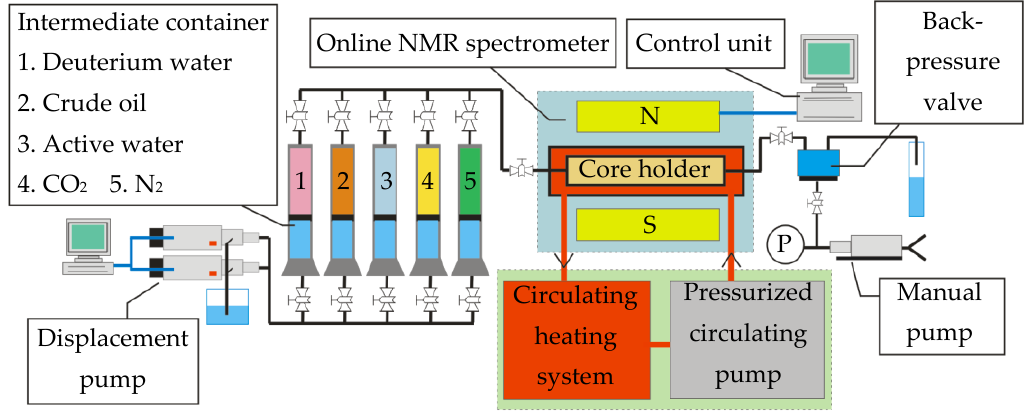
Figure 2. Flow chart of the experimental equipment.